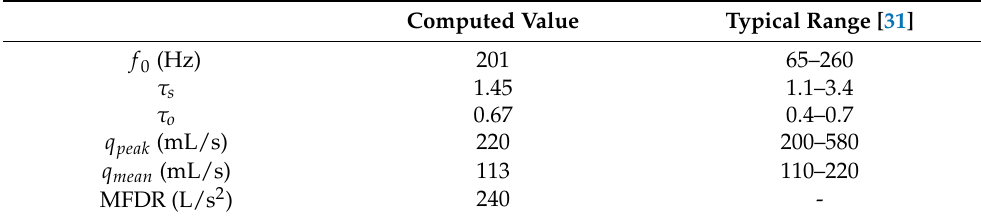
Figure 3. The phase-averaged flow rate over one vibration cycle in the baseline case. Table 2. Voice-quality-related quantities computed from the baseline model and their typical physiological ranges; f 0 is the fundamental frequency; τ s is the skewness quotient; τ o is the open quotient; q peak and q mean are the mean and peak glottal flow rates, respectively; MFDR is the maximum flow declination rate.